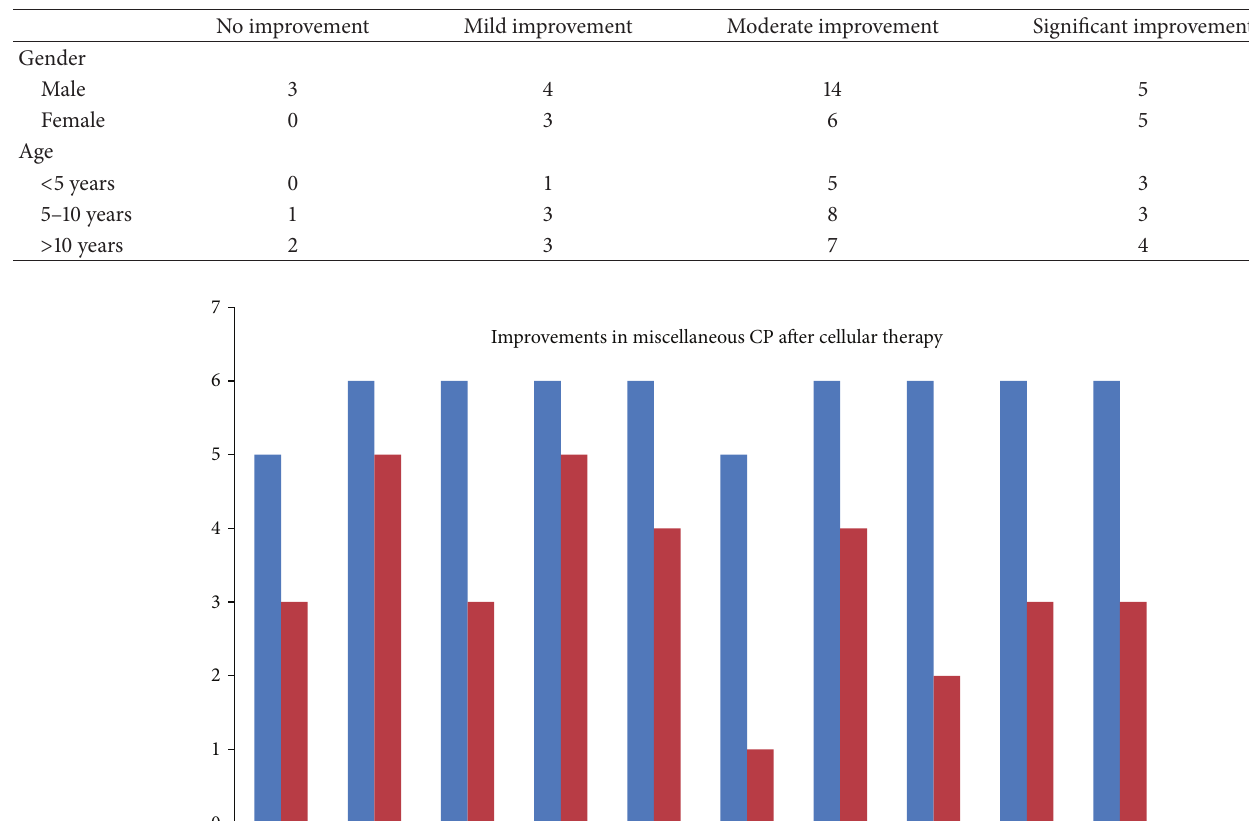
Table 2: Number of patients showing improvements based on gender and age of the patients 6 months after intervention.